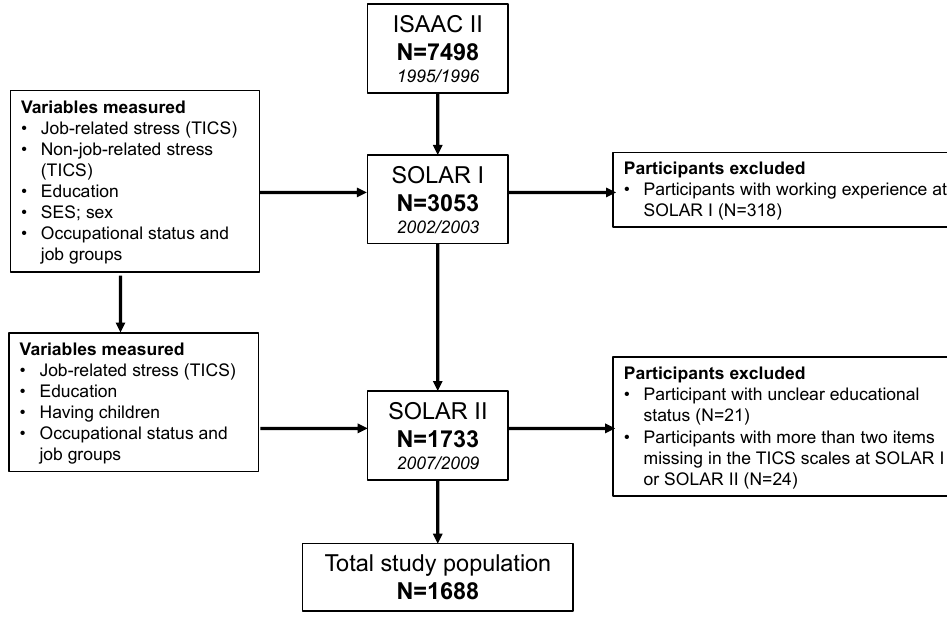
Figure 1. Flow chart of final sample size and the variables measured in each follow ‐ up.